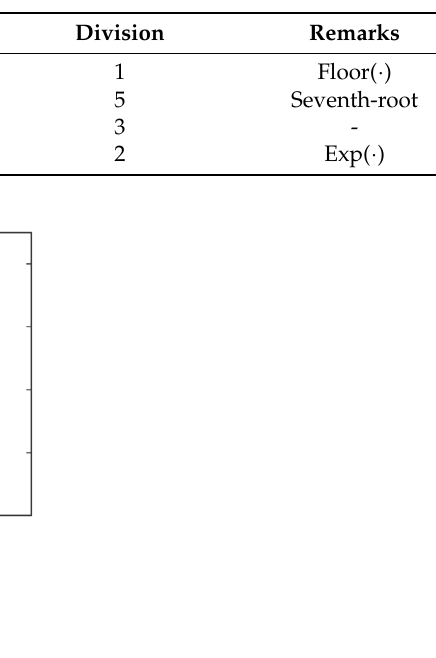
Figure 17. Numerical jitter calculation result with respect to the jerk dynamic stress. All adaptive DPLL algorithms have similar performances. Table 3. Theoretical computational complexities of each adaptive DPLL algorithm.